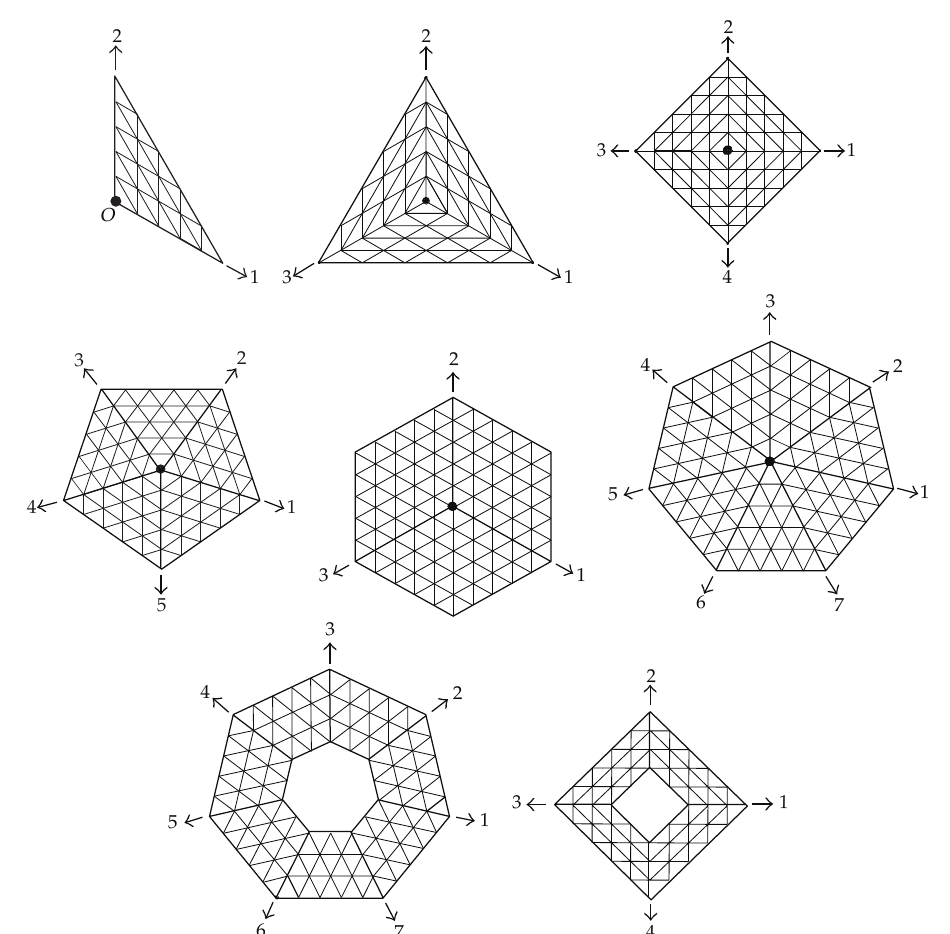
Figure 14: Weighted graph products in the shown coordinate system.